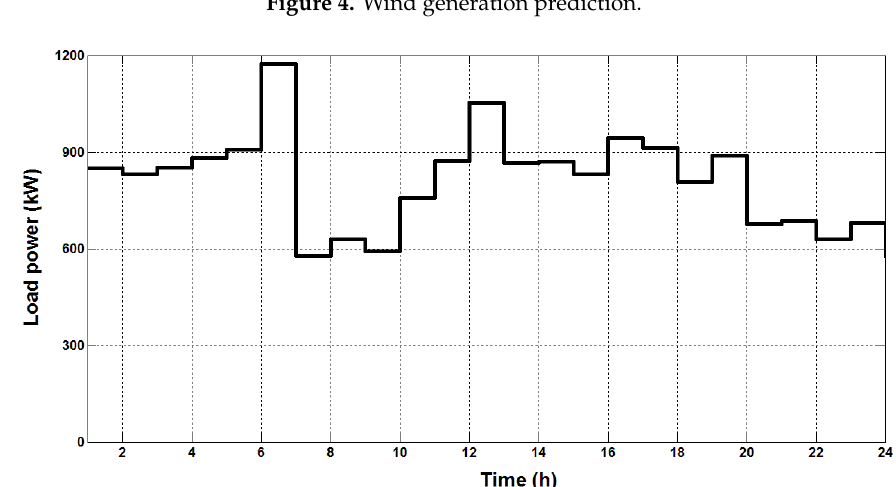
Figure 5. Electric load demand prediction.